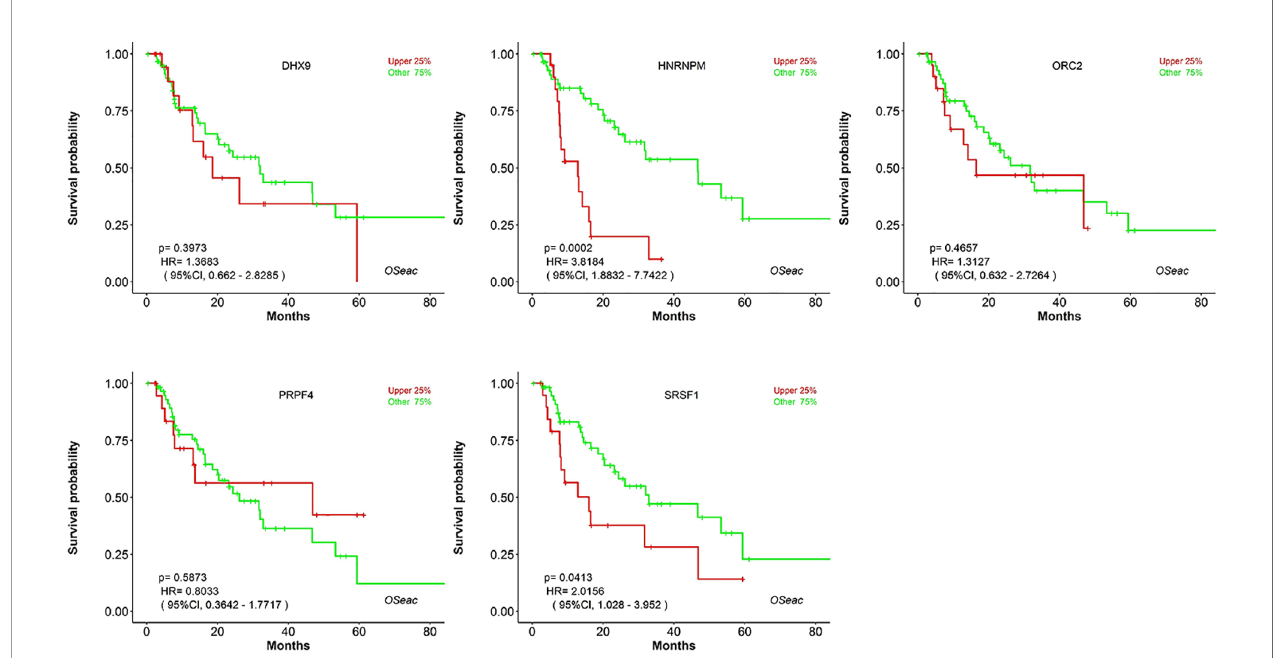
FIGURE 6 | The prognostic value of hub genes in BE and EAC patients (Kaplan – Meier